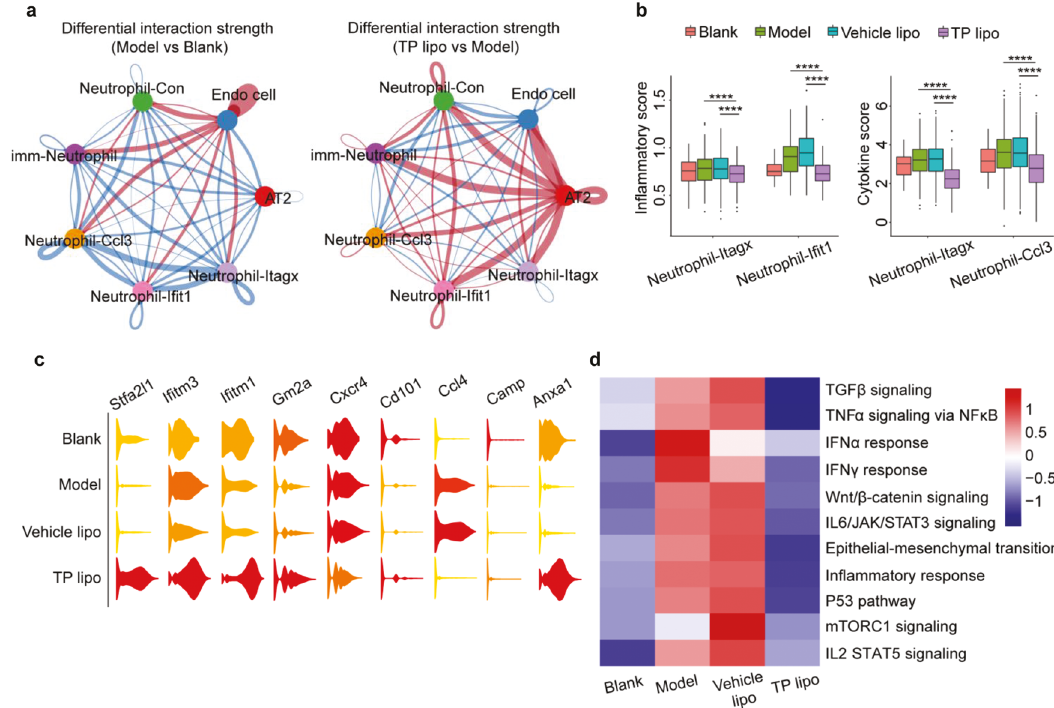
Fig. 7 TP lipo reduces the proin fl ammatory function of pulmonary neutrophils . a Differential interaction strength of signi fi cant ligand- receptor pairs between any pair of two cell populations. The edge width was proportional to the indicated strength of ligand-receptor pairs. Blue edge weakened cellular communication; Rea edge, strengthened cellular communication. b The cytokine score and the in fl ammatory score of Neutrophil-Itagx and Neutrophil-I fi t1 subpopulations in different groups. c Violin plots showing the expression of selected marker genes in four groups. Red, high expression; yellow, low expression. d Heatmap showing the expression of functional pathways of neutrophils in different groups. Signi fi cance is indicated by **** P ≤ (Fig. 7c). TP lipo has the potential to promote neutrophil apoptosis and in fl ammation resolution by upregulating the antiin fl ammatory protein annexin A1 (encoded by the Anxa1 gene ). 49,50 However, TP lipo treatment had a minimal effect on the